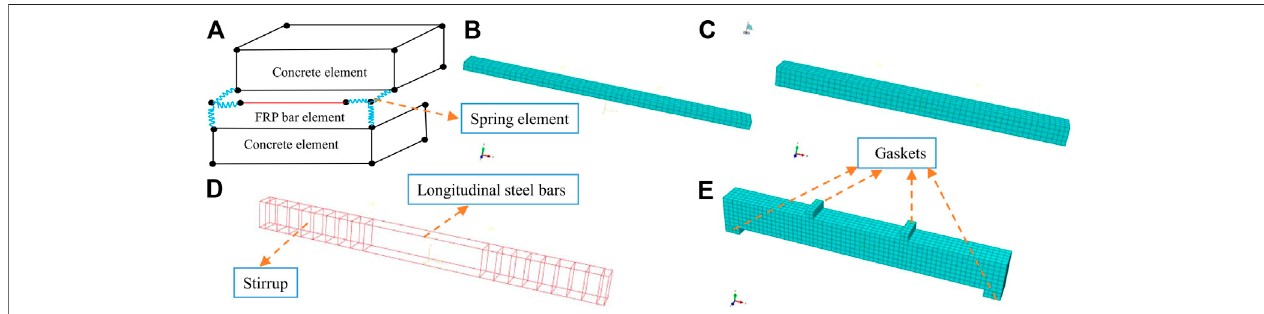
FIGURE 5 | FEM of simply supported beams consisting of gratitude concrete: (A) spring element; (B) HSC; (C) NSC; (D) reinforcing cage; (E) overall mesh generation of simply supported beams.